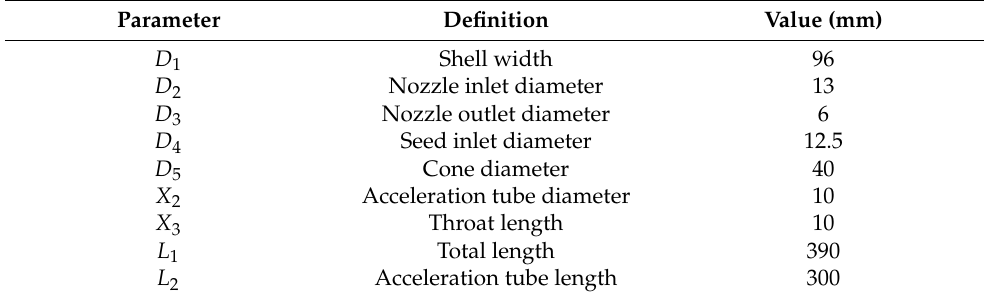
Table 1. Geometric information of the PWSD.